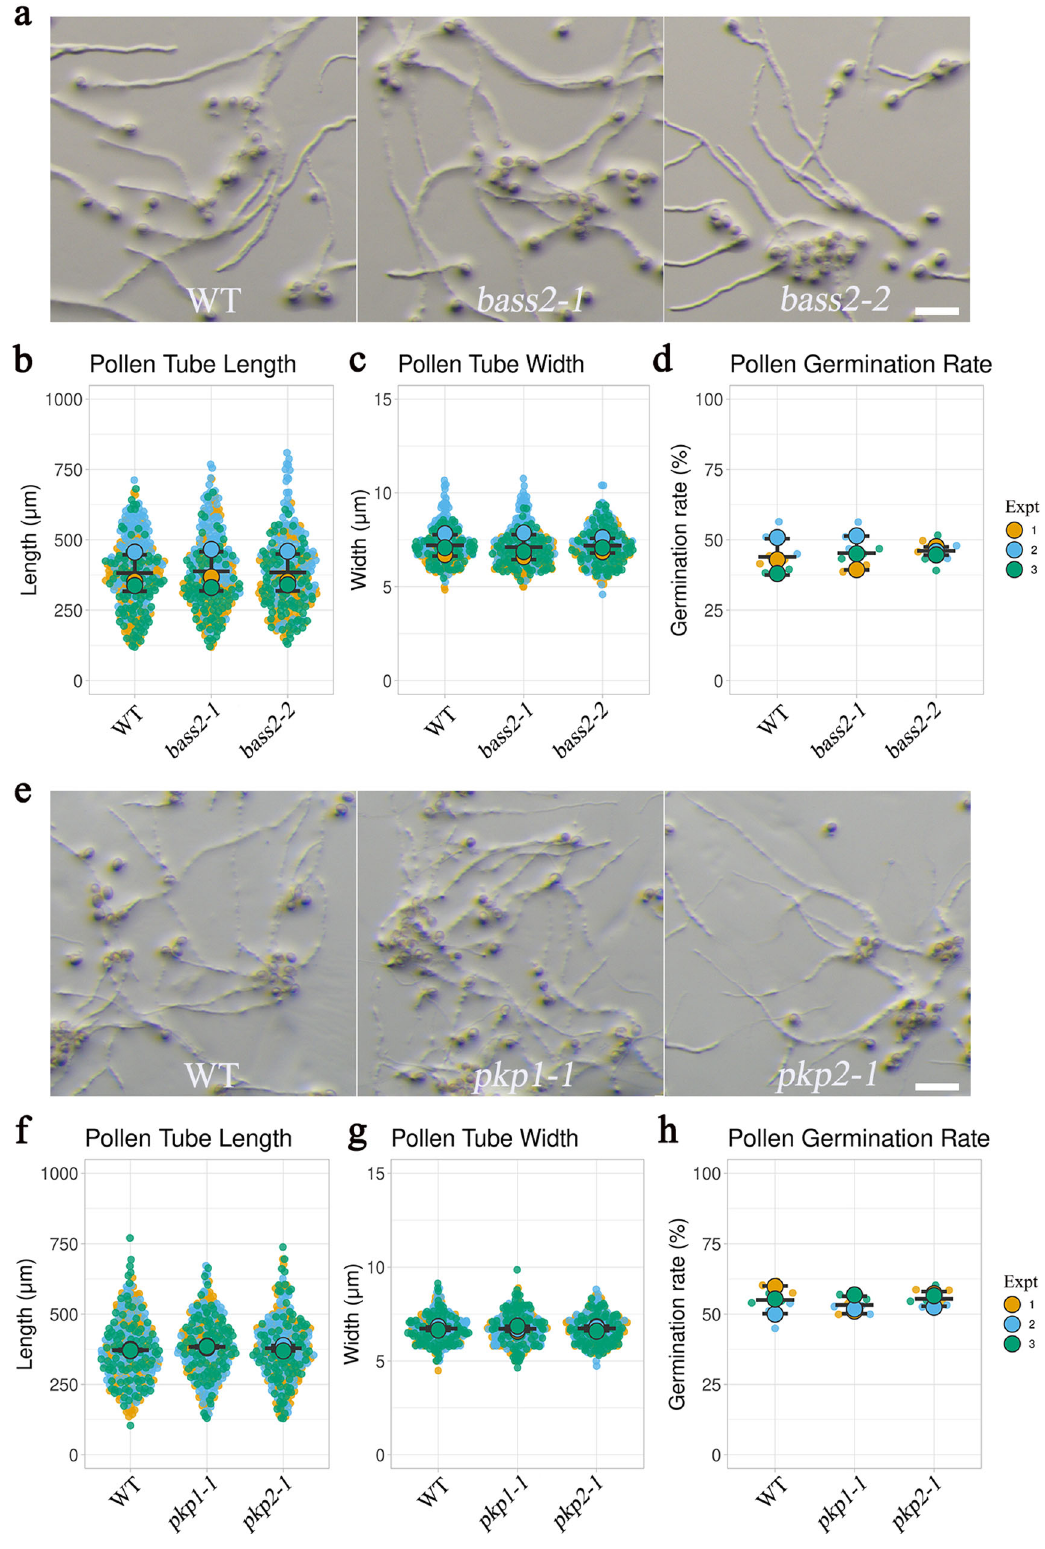
Fig.5|Sourceofpyruvateinpollenplastids.a Invitropollengerminationassays for the WT and two homozygous bass2 T-DNA mutants. b – d Pollen tube length, pollen tube width, and pollen germination rate of the WT and bass2 mutants. p valuesofpanelb=0.800( bass2-1 )and0.980( bass2-2 ). p valuesofpanelc=0.4143 ( bass2-1 ) and 0.9621 ( bass2-2 ). p values of panel d=0.8125 ( bass2-1 ) and 0.6206 ( bass2-2 ). e PollentubegrowthofWTand pkp1-1 , pkp2-1 knockoutlines. f – h Pollen tube length, width and germination rate were compared between WT and pkp1-1 ,